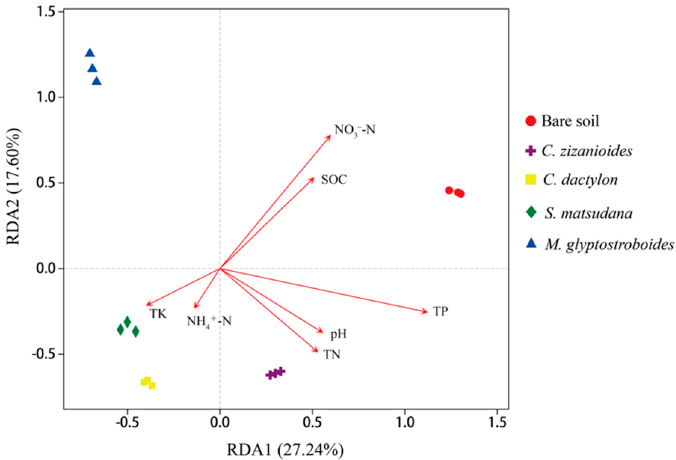
Figure 5. Redundancy analysis (RDA) of bacterial communities and physicochemical characteristics of soil.